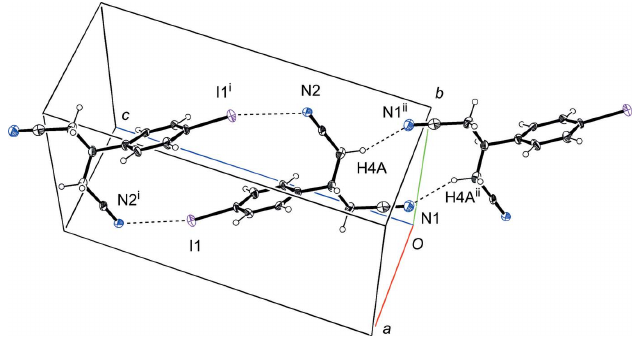
Figure 2 A view of the intermolecular interactions in the title compound [symmetry codes:(i) (cid:4) x + 1, (cid:4) y , (cid:4) z + 1; (ii) (cid:4) x , (cid:4) y , (cid:4) z